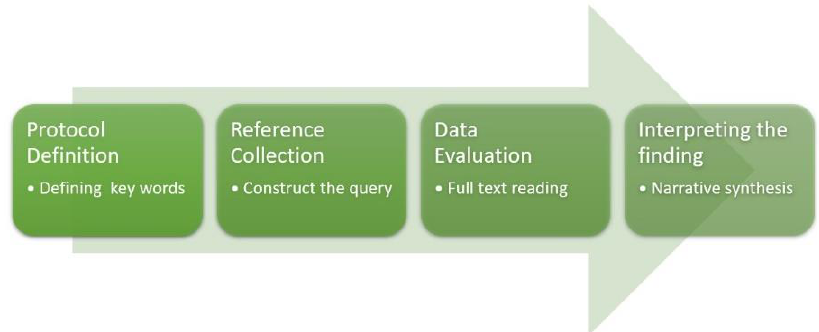
Figure 2. Phases of the SLR protocol followed to find links between previous work reported in [18], recent educational literature, and the present research proposal. Details of the SLR can be reviewed in Appendix A.